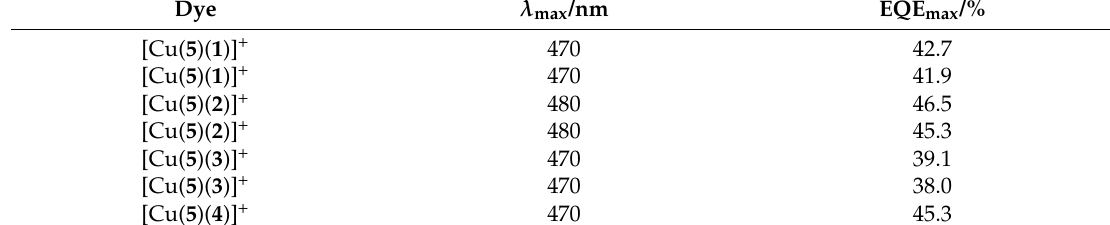
Table 3. EQE maxima for duplicate DSSCs containing dyes [Cu( 5 )(L ancillary )] + (L ancillary = 1 – 4 ).